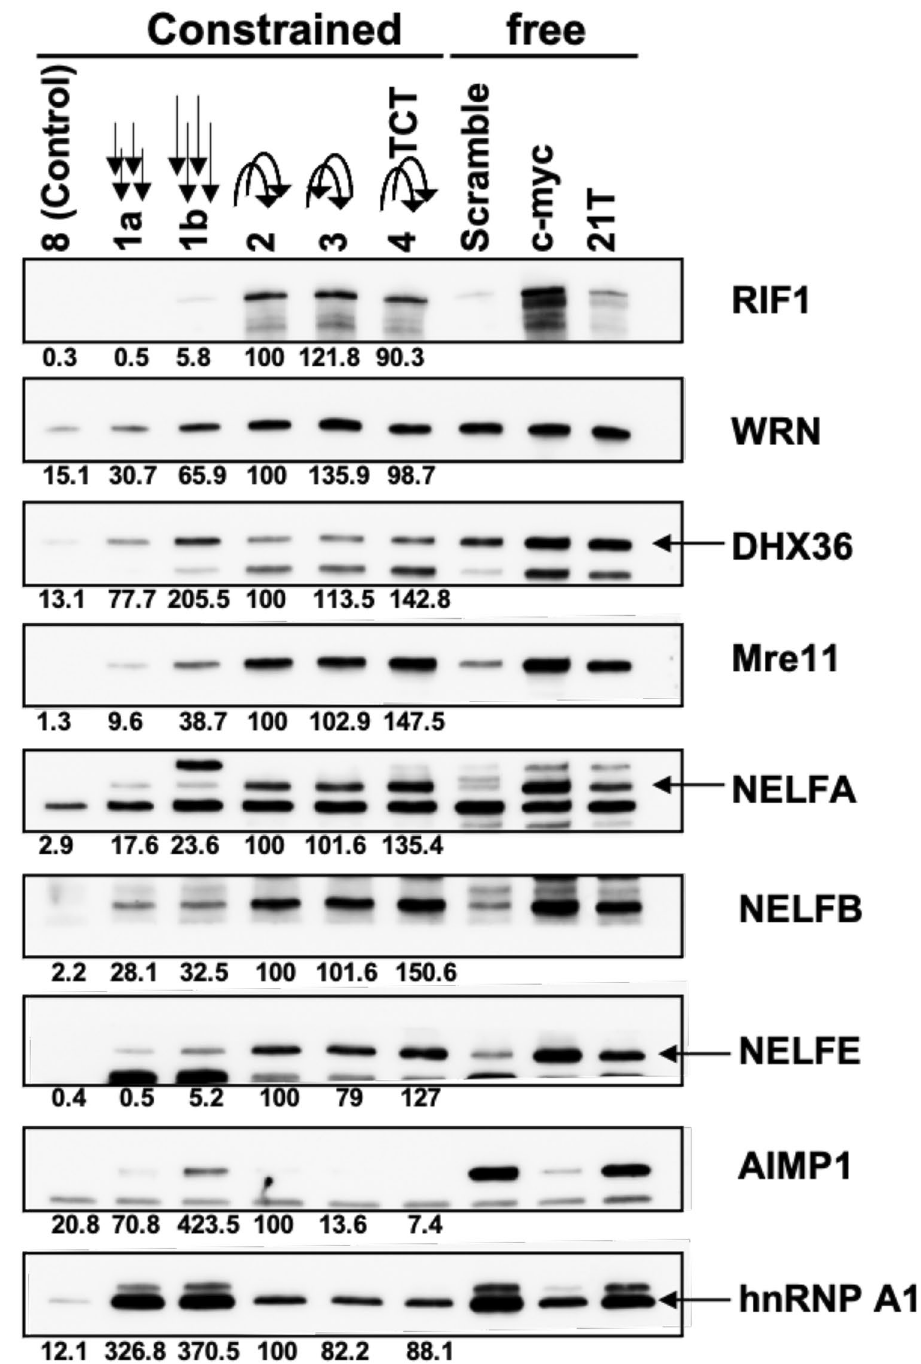
Figure 5. Impact of the orientation and nucleotide composition of connecting loops on the differential enrichment of proteins on G4 structures. Western-blotting analysis and quantification of the interaction of proteins found enriched on constrained G4 structures with modified molecules ( 1a , 1b , 2 , 3 , 4 ) and with unconstrained G4 (c-myc and 21 T). Arrows indicate the 5 ′ -3 ′ strand orientation of single-stranded extensions or connecting loops present on different systems. The modification of the nucleotide composition of connecting loops in the system 4 is indicated by the sequence TCT. Construct 8 and scramble sequence were used as control for pull-down performed with constrained of free-G4 structures,